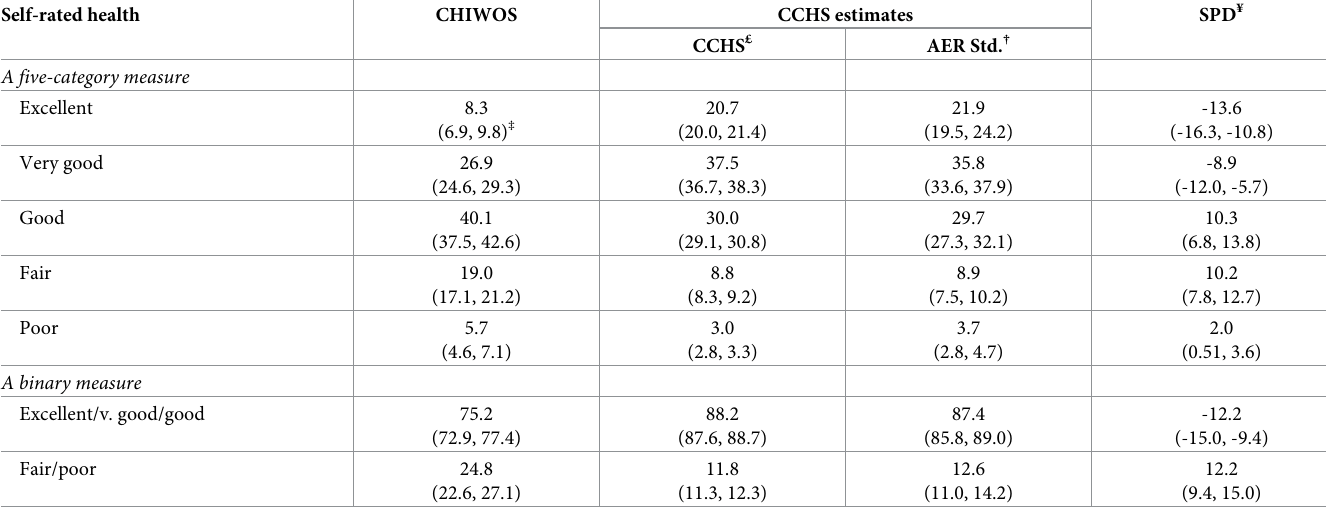
Table 4. Comparing self-rated overall health status between women living with HIV (CHIWOS; 2013–2015) and the general population of women in Canada (CCHS; 2013–2014) �